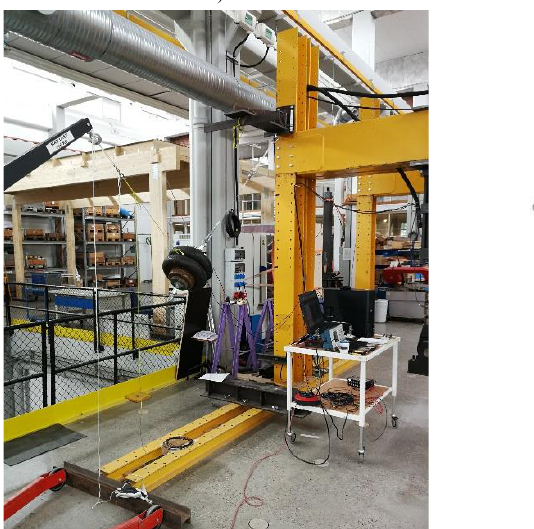
(provided by DIN 18008-4) tested against a rigid wall for the drop heights of 200 and 450 mm are also presented. The experimental results obtained in this study fit within this